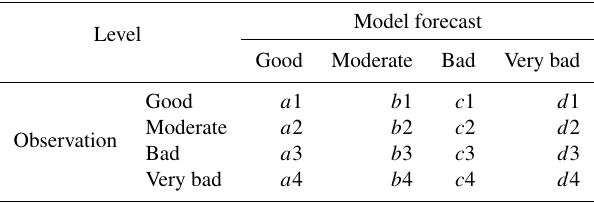
Table 4. Intervals corresponding to the four categories for calculat- ing ACC, POD, FAR, and recall and precision: “good” (PM 2 . 5 ≤ 15µgm − 3 ); “moderate” (16µgm − 3 ≤ PM 2 . 5 ≤ 35µgm − 3 ); “bad” (36µgm − 3 ≤ PM 2 . 5 ≤ 75µgm − 3 ); and “very bad” (76µgm − 3 ≤ PM 2 . 5